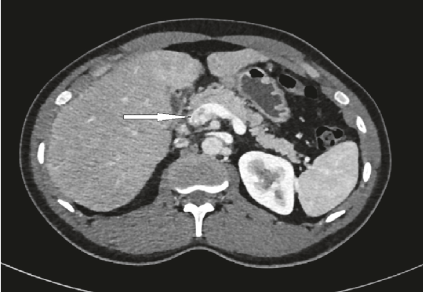
Figure 2: Contrast-enhanced CT scan abdomen showing partial filling defect in the portal vein (white arrow).